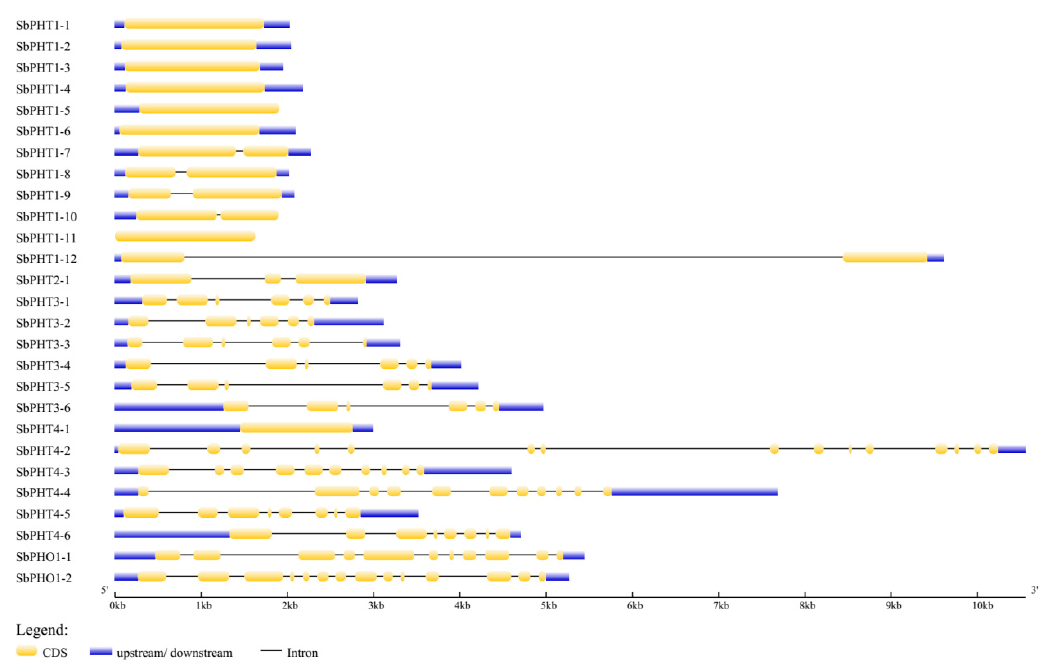
Figure 3. Gene structures of PHT genes in Sorghum . The full-length mRNA sequences of SbPHT genes are analyzed and displayed. The yellow boxes represent coding sequence (CDS), whereas the blue boxes represent upstream or downstream untranslated regions (UTRs). The introns in coding sequence are shown as black lines. The scale bar at the bottom indicates the length of the SbPHT genes in Kb.